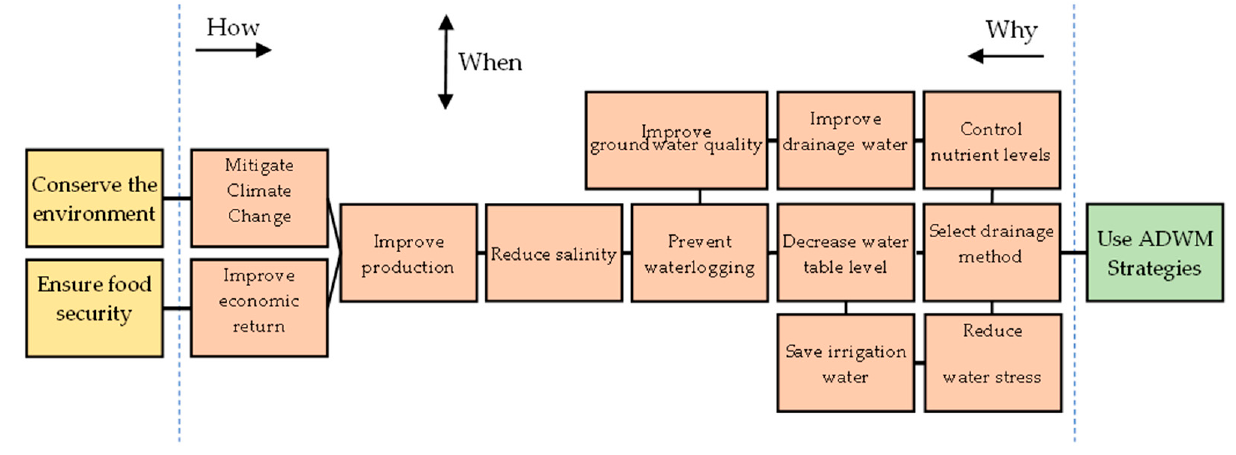
Figure 1. Fast diagram for ADWM strategies.